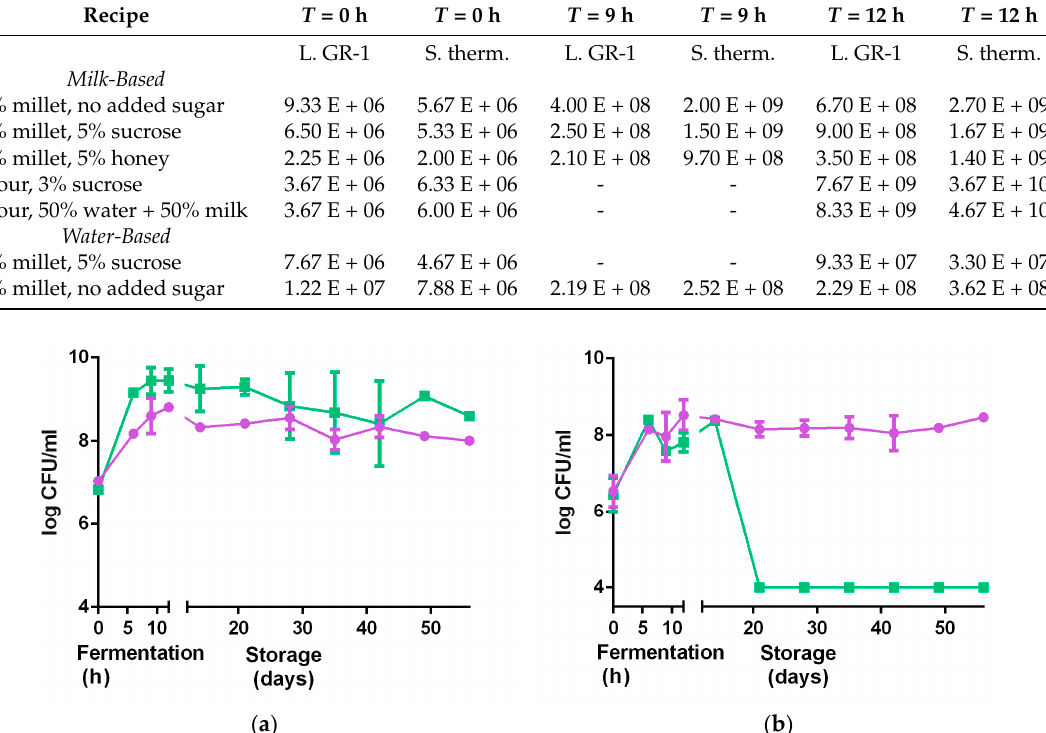
Figure 5. Changes in viable bacteria counts of L. rhamnosus GR-1 ( ● ) and S. thermophilus C106 ( ■ ) during fermentation (12 h) and refrigerated storage (56 days). ( a ): 4% millet in milk with 5% sucrose;